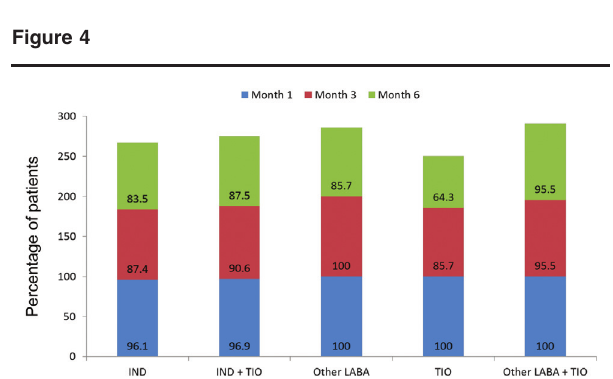
Persistence with treatment at month 1, 3 and at the end of the study. Full analysis set. Persistence is defined as a patient who is still taking the original COPD medication recorded, at baseline, at each subse- quent time point. COPD, chronic obstructive pulmonary disease; LABA, long-acting β 2 -agonist; TIO, tiotropium; IND,